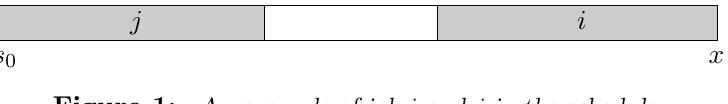
Figure 1: An example of job i and j in the